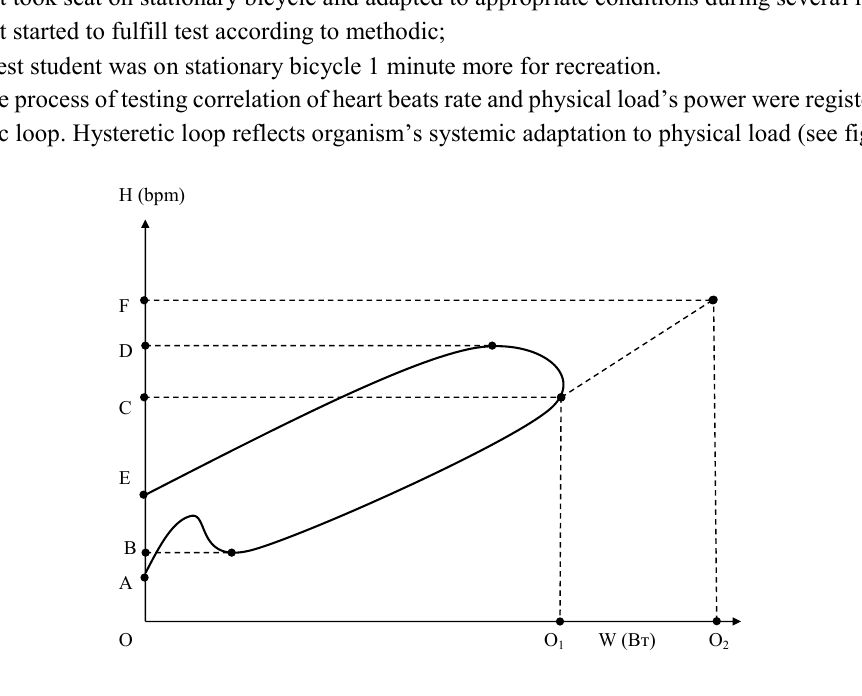
Fig.2. Dynamic of heart beats rate in functional testing: Н – heart beats rate (HBR); W – power of load; А – initial HBR; B – threshold HBR; С – reverse HBR; D – maximal HBR; Е – HBR of coming out of load. F –HBR=170 bpm -1 .